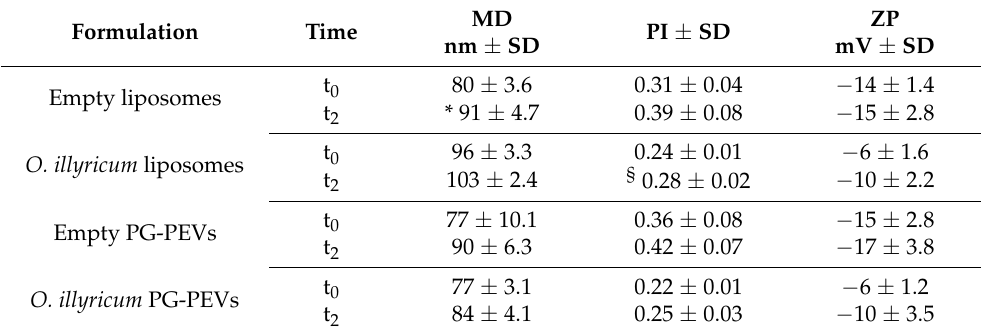
Table 4. Mean diameter (MD), polydispersity index (PI), and zeta potential (ZP) of empty and O. illyricum liposomes and PG-PEVs after 2 months of storage (t 2 ) vs. the data generated from time zero (t 0